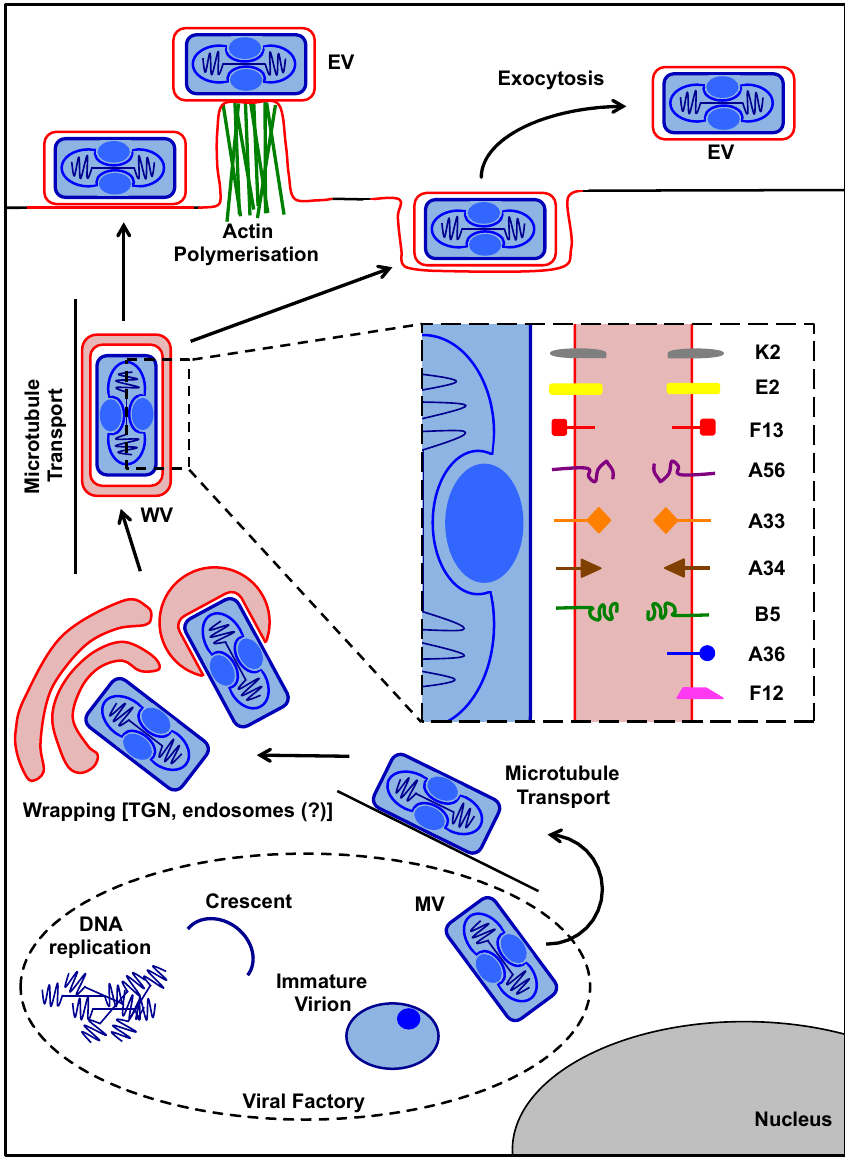
Figure 3. VACV MV to EV. After assembly within the cytoplasmic virus factory, a subset of MVs are transported on microtubules to the site of wrapping in the region of the microtubule organising center. The wrapping membranes are thought to be derived from the trans-Golgi network (TGN), or potentially LEs, and EEs after recycling of EV proteins from the plasma membrane. MV wrapping results in the formation of a triple membrane WV. WVs contain 9 additional proteins (illustrated in the zoom box) not found in MVs that direct the wrapping, post-wrapping transport, exocytosis and virus spread. Once formed, WVs are transported to the cell surface on microtubules. Upon reaching the plasma membrane the outermost WV membrane undergoes fusion thereby exocytosing the underlying double-membrane enveloped EV. EVs can either remain associated with the producer cell, detach from the cell surface to mediate long distance spread, or by the action of actin tails be propelled away from the cell surface to facilitate cell-to-cell spread. VACV: vaccinia virus; MV: mature virion; WV: wrapped virion; EV: extracellular virion; LE: late endosome; EE: early endosome.